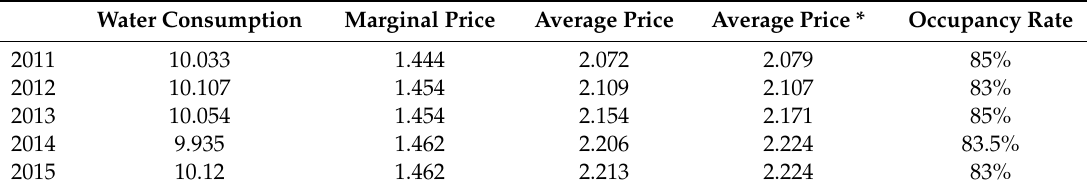
Table 4. Median of key variables per year.